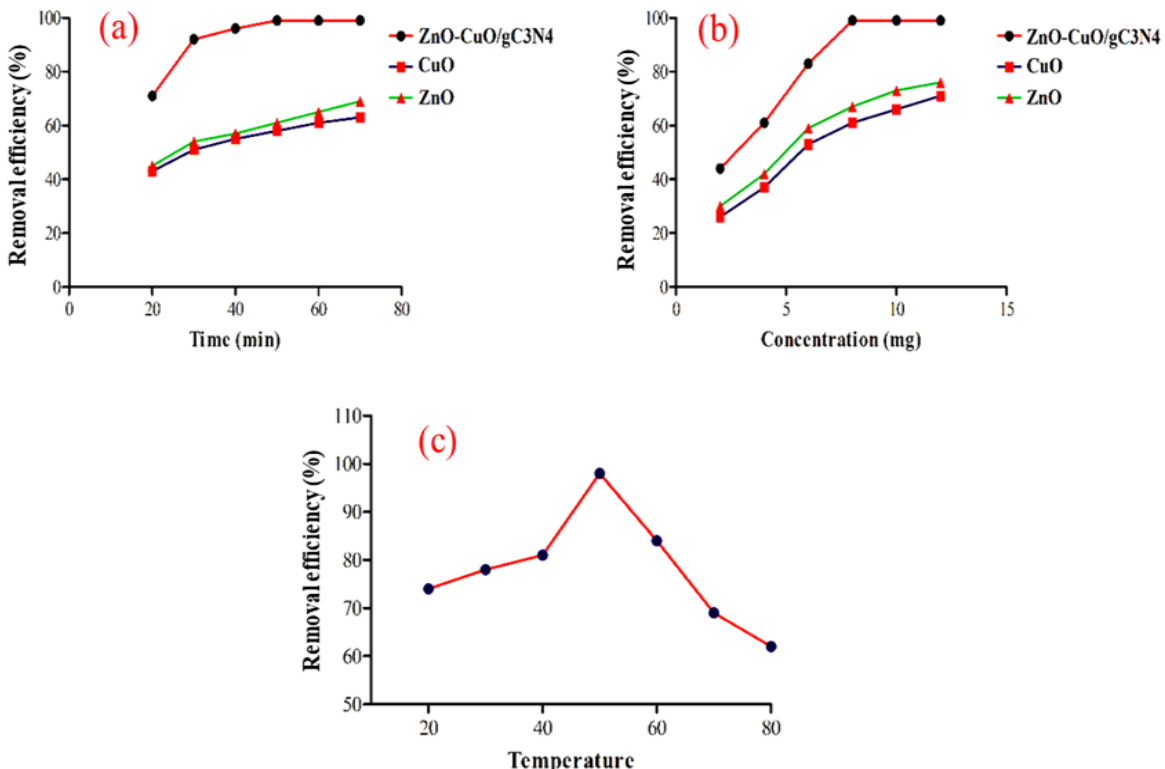
Figure 7. ( a ) Effect of time, ( b ) concentration of nanomaterial, ( c ) temperature on the adsorption of arsenic.